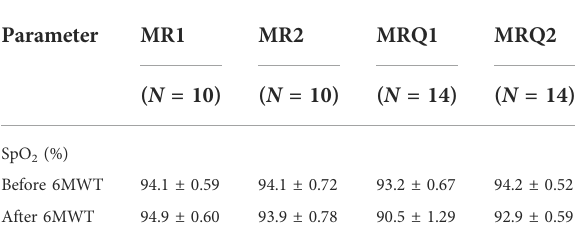
TABLE 1 Effect of rehabilitation program on blood oxygen saturation of patients with post